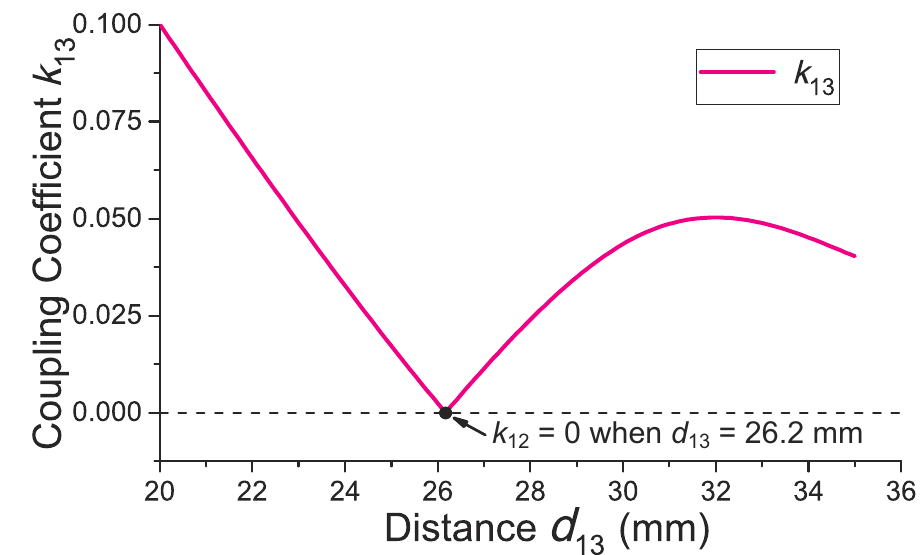
Figure 5. Calculated coupling coefficient ( k 13 ) versus different d 13 . There is an optimal d 13 where k 13 is minimized to approach zero, due to the balanced inside and outside magnetic flux from the external power